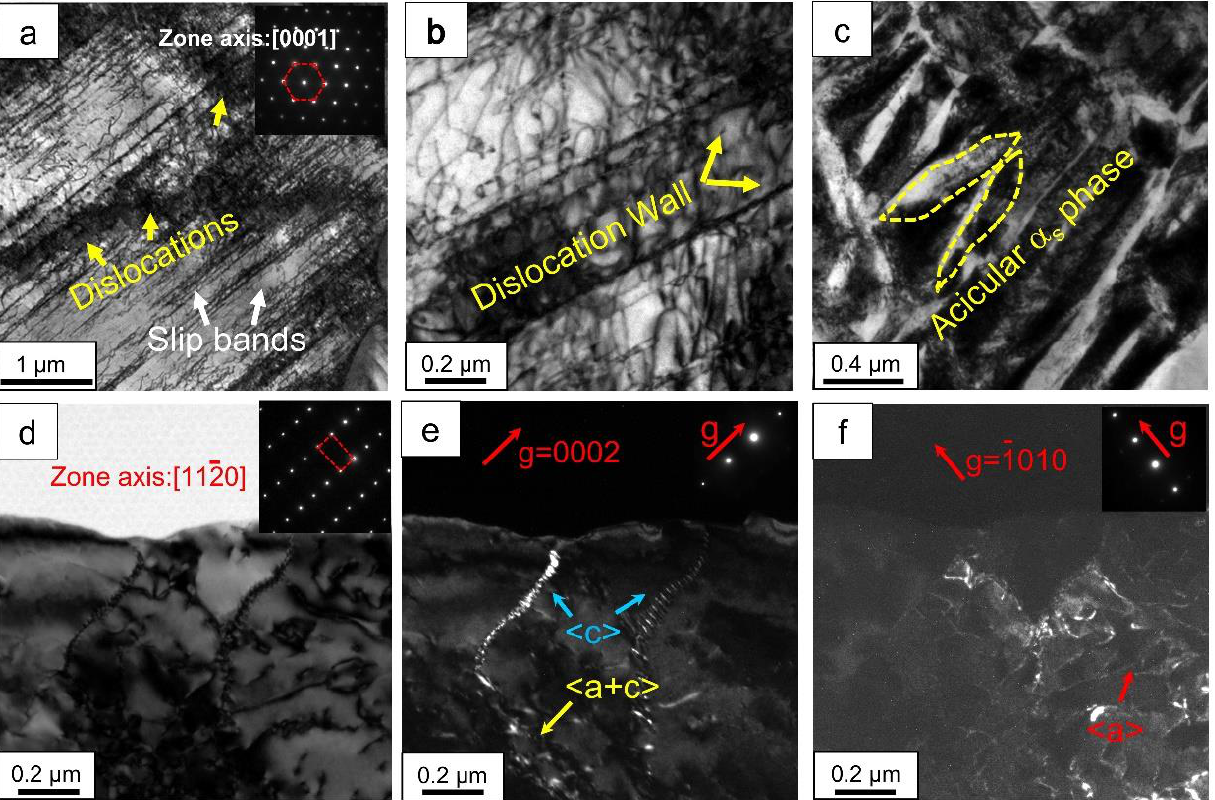
Figure 6. TEM images show the deformation features of the heat treatment LD-Ti423 alloy. ( a,b ) represent the dislocation slip bands in α phase; ( c ) acicular α s phases hinder the slipping of dislocations; ( d ) dislocation morphology along the [1120] direction and two-beam ( e,f ) WBDF images showing dislocation structures under ( e ) g = [0002] and ( f ) g = [ 1 010].